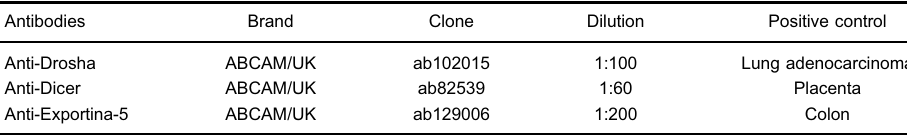
Table 1 . Description of antibodies used in the study.